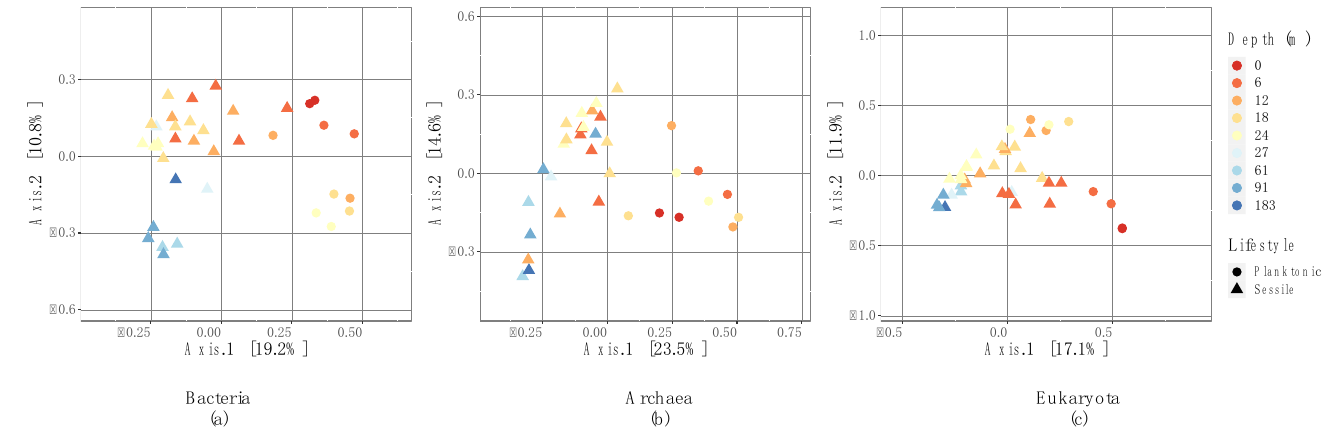
Figure 3. Principal coordinates analysis (PCoA) ordination of bacterial ( a ), archaeal ( b ), and eukaryote ( c ) community variance based on a Bray-Curtis dissimilarity matrix. The dotted lines indicate 95% confidence interval groups by lifestyle. Table 1. Variation in bacterial, archaeal and eukaryote community composition explained by depth,